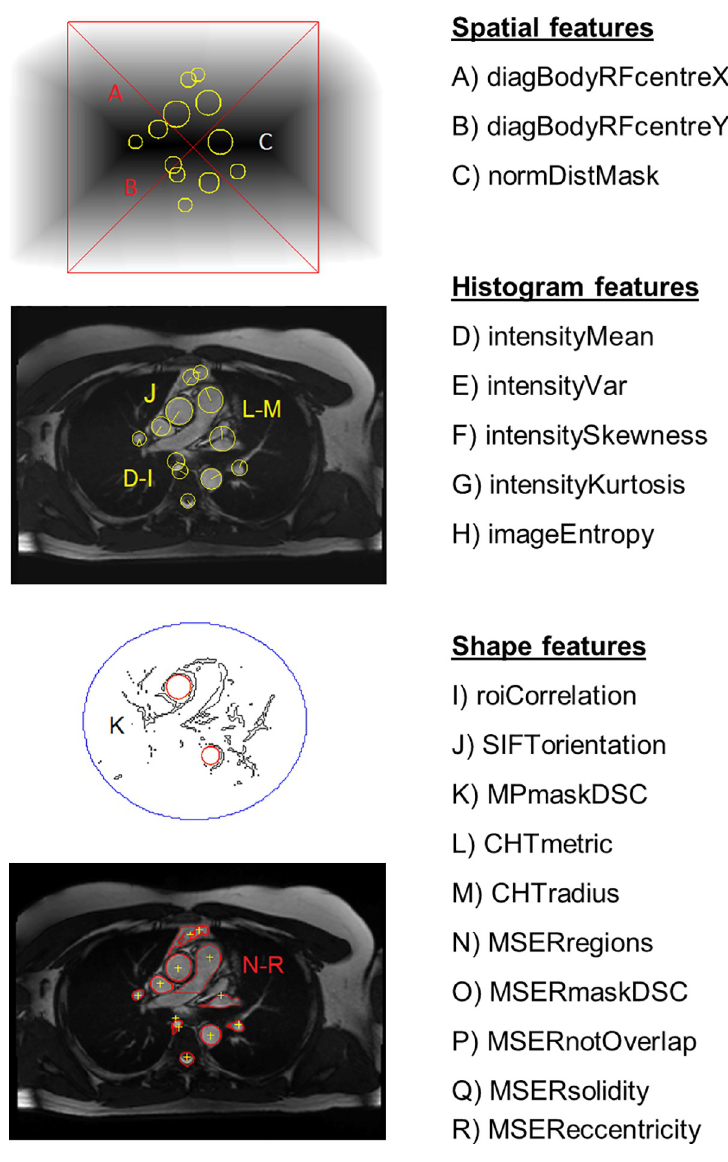
Fig 3. ROI features. Graphical representation and list of local features (A-R) extracted for each candidate ROI (yellow circles) and divided into groups. Spatial features: diagonal axes A-B and distance mask C of the body. Shape features: J is indicated by the line inside the circles; K is represented by the red circles on the Motion Periodicity (MP) map; L and M describe the circles detected by the Circular Hough Transform (CHT); and N-R characterize the Maximally Stable Extremal Regions (MSER) marked by the red contours. Graphical representation was not possible for features D-I. Please refer to the methods section in the main text for the definition of each image feature.